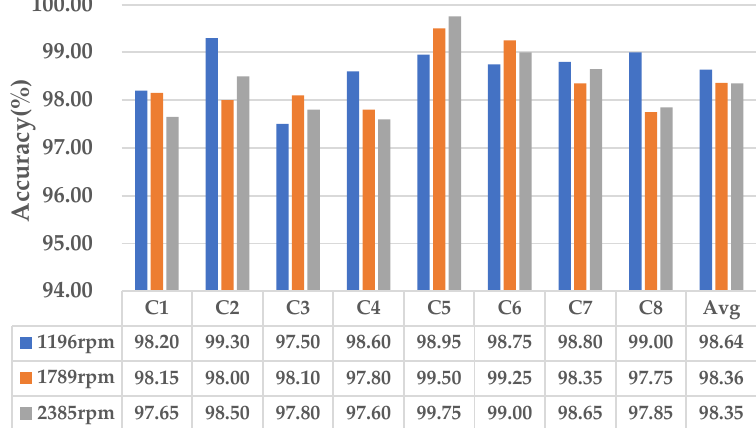
Figure 15. The recognition accuracy for each health condition.